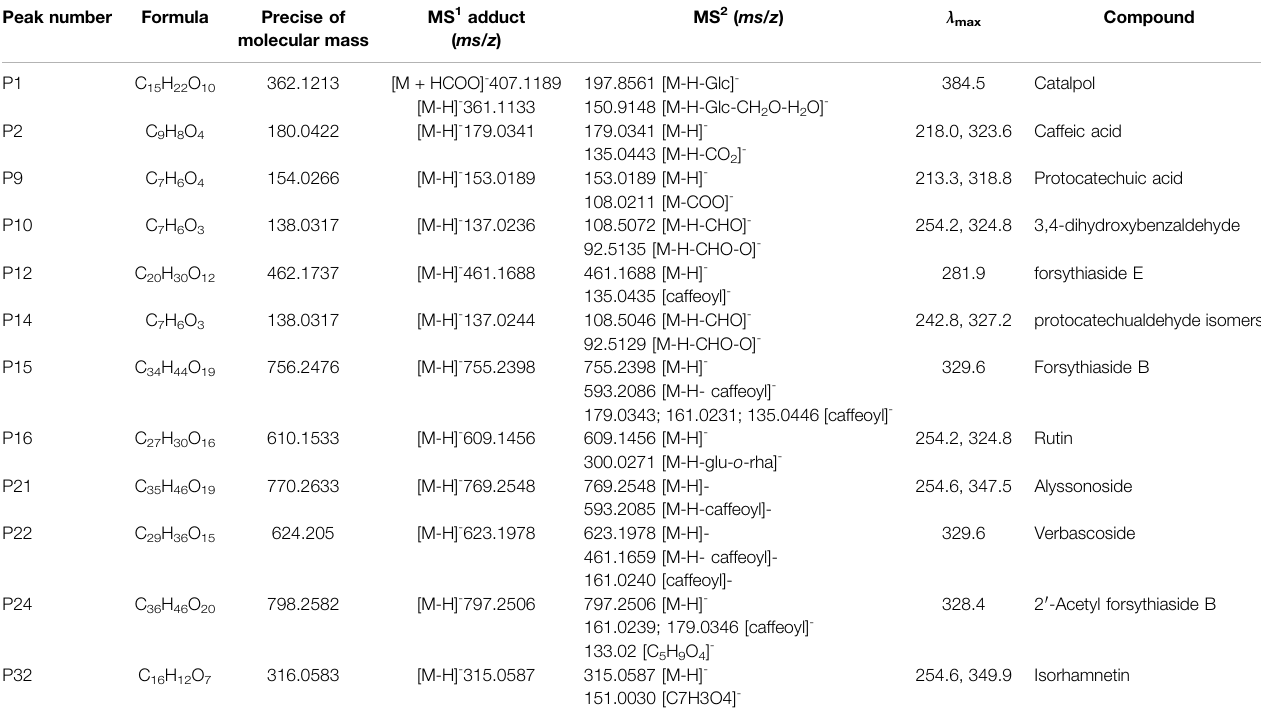
TABLE 4 | Identi fi cation results of spectral ef fi ciency related peaks by UPLC-DAD-Q/TOF-MS. Peak number